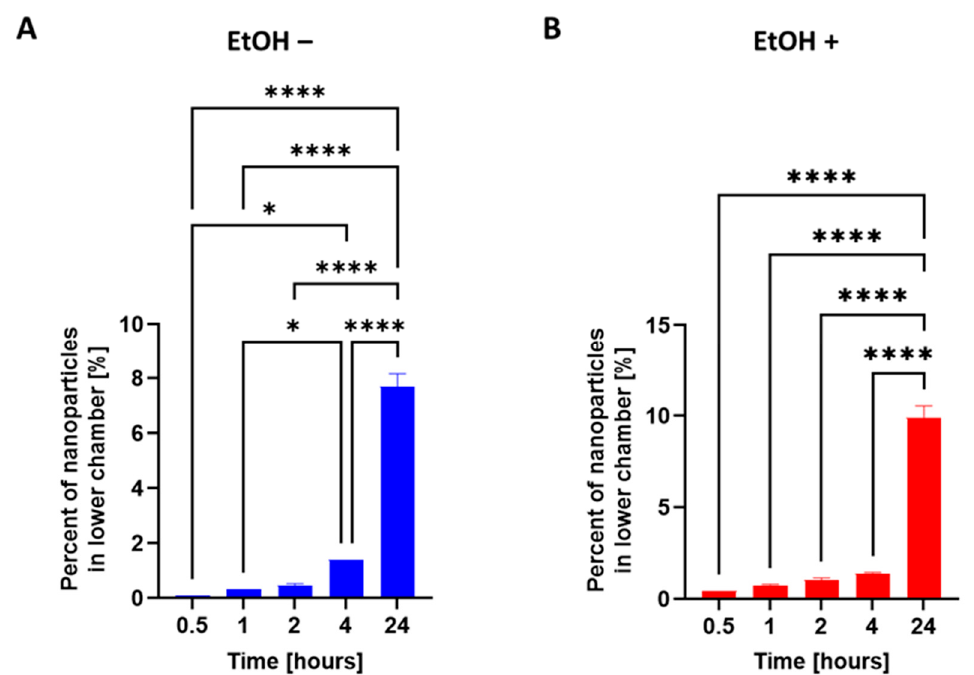
Figure 9. Nanoparticle migration through an in vitro model of the blood–brain barrier. The apical side of the model was treated with either the ( A ) PBS vehicle (EtOH − ) or ( B ) 10 mM of ethanol (EtOH +) for 24 h, after which time a suspension of fluorescently tagged nanoparticles was added. The migration of nanoparticles was observed at 0.5, 1, 2, 4, and 24 h. The data were analyzed using a one-way ANOVA with Tukey’s multiple comparisons test. The results are presented as mean values (±SEM, N = 4 individual models). Significant differences are indicated by * p ≤ 0.05 and **** p ≤ 0.0001.